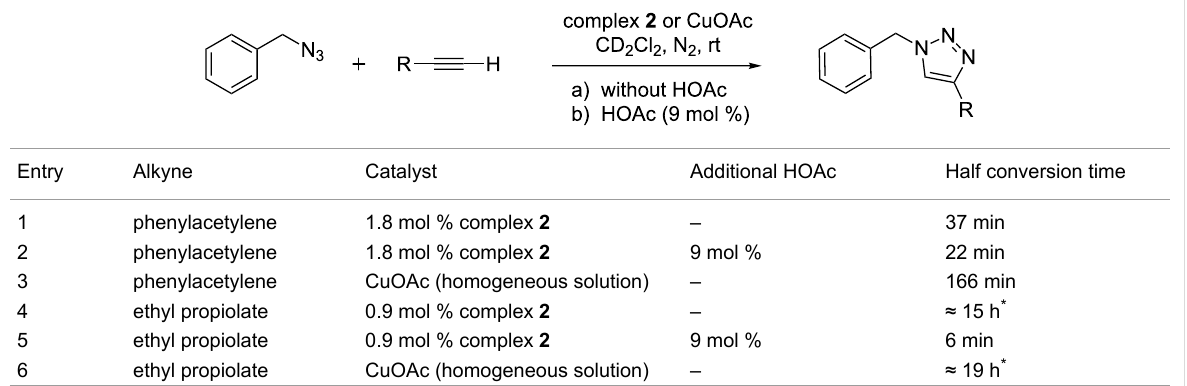
Table 1: CuAAC reaction of benzyl azide and terminal alkynes with complex 2 or CuOAc as catalyst in absence or presence of added acetic acid.